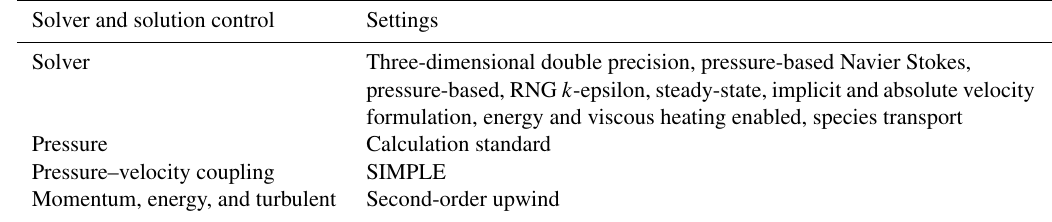
Table 2. Summary of the FLUENT settings used for the CFD simulations. Solver and solution control Settings Solver Three-dimensional double precision, pressure-based Navier Stokes, pressure-based, RNG k -epsilon, steady-state, implicit and absolute velocity formulation, energy and viscous heating enabled, species transport Pressure Calculation standard Pressure–velocity coupling SIMPLE Momentum, energy, and turbulent Second-order